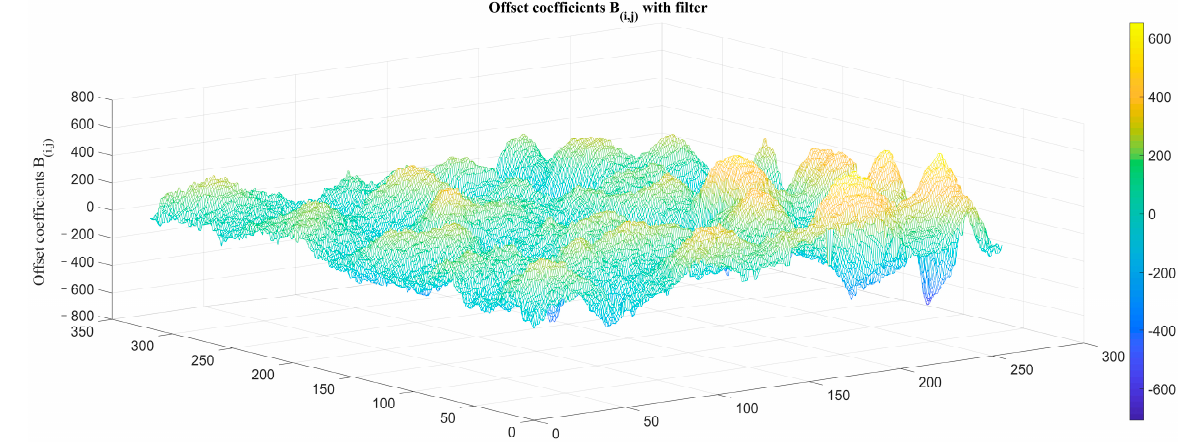
Figure 15. TPC offset coefficients B i,j with atmospheric transmittance filter. The overall trend of TPC coefficients of the two groups is consistent, but some details are quite different. The deviation is shown in Figures 16 and 17.